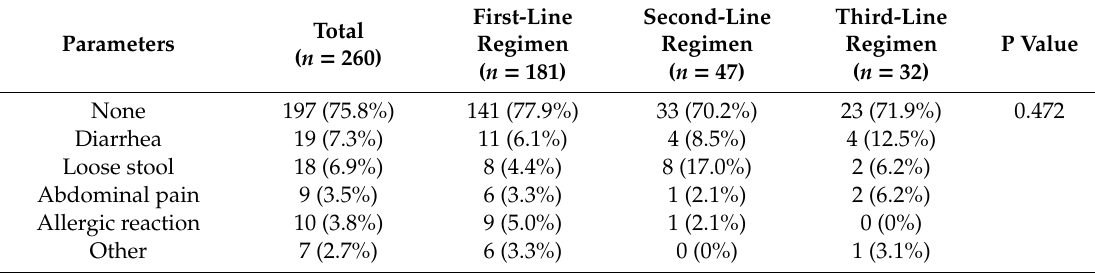
Table 4. Adverse events related to eradication